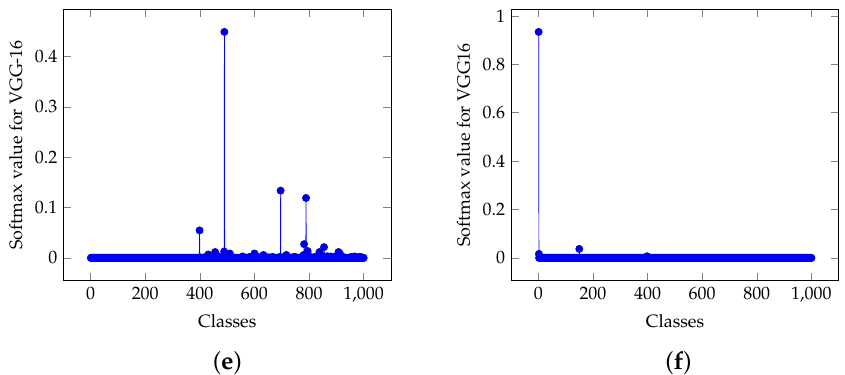
Figure 8. Actual and proposed approximation softmax values for two inferences, namely A and B, for the VGG-16 CNN. ( a ) Actual softmax values for inference A. ( b ) Actual softmax values for inference B. ( c ) Proposed approximation softmax values for inference A based on architecture of Figure 2a and (18). ( d ) Proposed approximation softmax values for inference B based on architecture of Figure 2a and (18). ( e ) Proposed approximation softmax values for inference A based on architecture of Figure 2b and (30) with p = 10. ( f ) Proposed approximation softmax values for inference B based on architecture of Figure 2b and (30) with p = 10.